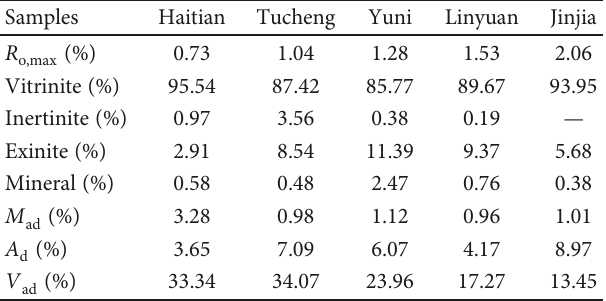
Table 1: Vitrinite re fl ectance, macerals, and proximate analysis.